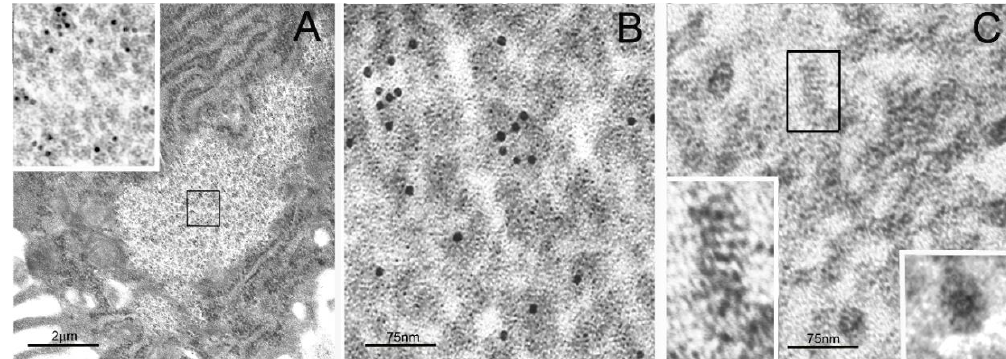
Figure 1. Transmission electron microscopy (TEM) of particulate cytoplasmic structure (PaCS) and high-resolution structure of its proteasome-reactive barrel-like particles. ( A ) Foveolar cell of Helicobacter pylori -infected human gastric epithelium showing a clear cytoplasmic area filled with particles, enlarged in the inset (from the boxed area in ( A ); 60,000×), to recognize their barrel-like structure and 20S proteasome immunogold reactivity, typical of PaCS. Note ribosome-rich endoplasmic reticulum (ER) surrounding the PaCS. ( B ) Enlarged PaCS particles showing 19S proteasome immunoreactivity, while in ( C ) a longitudinally oriented particle is boxed and further enlarged in the left-bottom inset (600,000×) to show a side view of the four 20S-core parallel rings, apparently capped at both higher and lower extremities with a 19S regulatory component. Compare with Figures 1, 3, and 4 of Reference [20]. In the bottom right inset of ( C ), a top view of another particle exhibiting the known seven-fold starlike symmetry of the proteasome particle. Reproduced and adapted from Reference [17], under a Creative Commons Attribution (CC BY 4.0) International License.